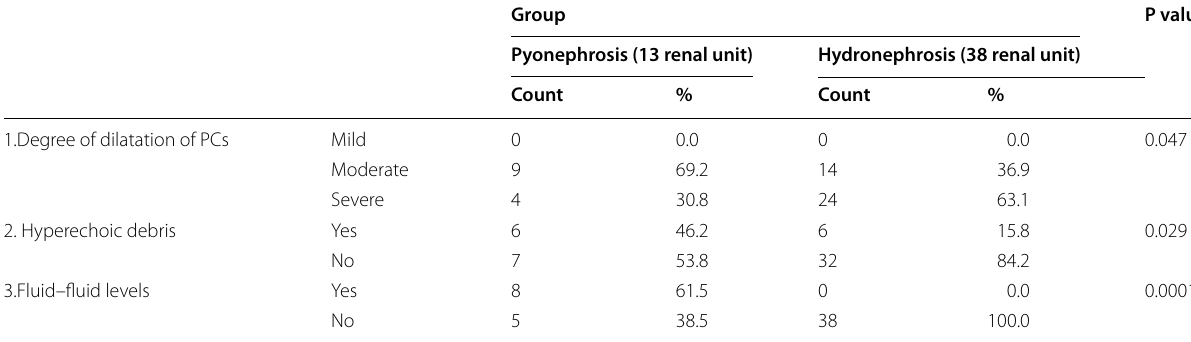
Table 3 Ultrasound findings among study groups